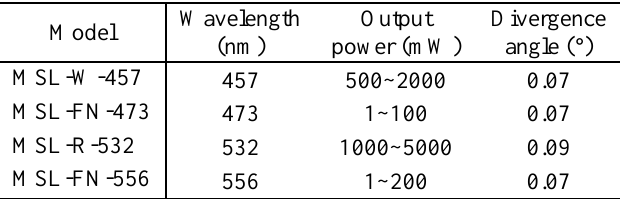
Table 3. Bit error rate performance for